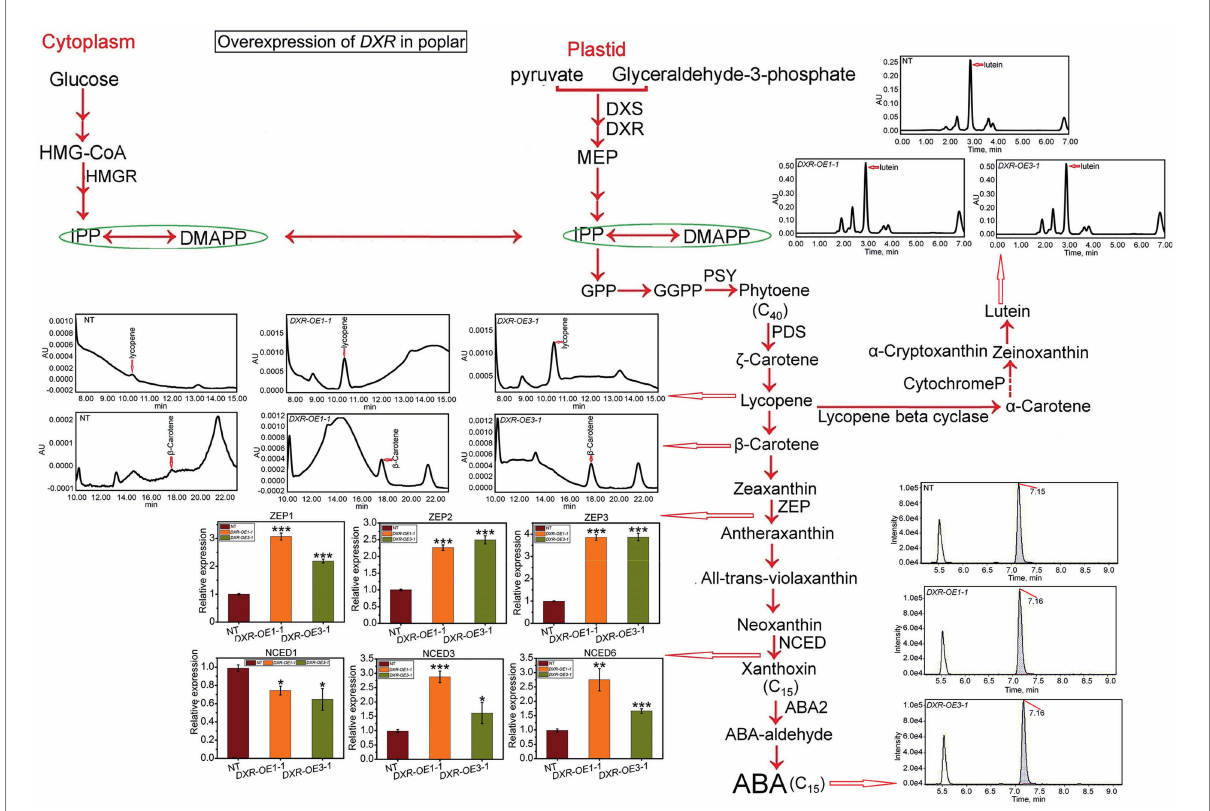
FIGURE 4 Assessment of the impact of PtDXR overexpression on isoprenoid and ABA biosynthesis. The qRT-PCR analyses of the expression levels of ABA synthesis-related genes and HPLC-MS/MS analyses of the contents of ABA, β -carotene, lycopene, and lutein in PtDXR -OEs. The expression levels of the ABA synthesis-related ZEP and NCED genes family are indicated. Bars represent mean ± SD ( n = 3); Stars reveal significant differences, * p < 0.05, ** p < 0.01, *** p < 0.001; Experiments were performed in